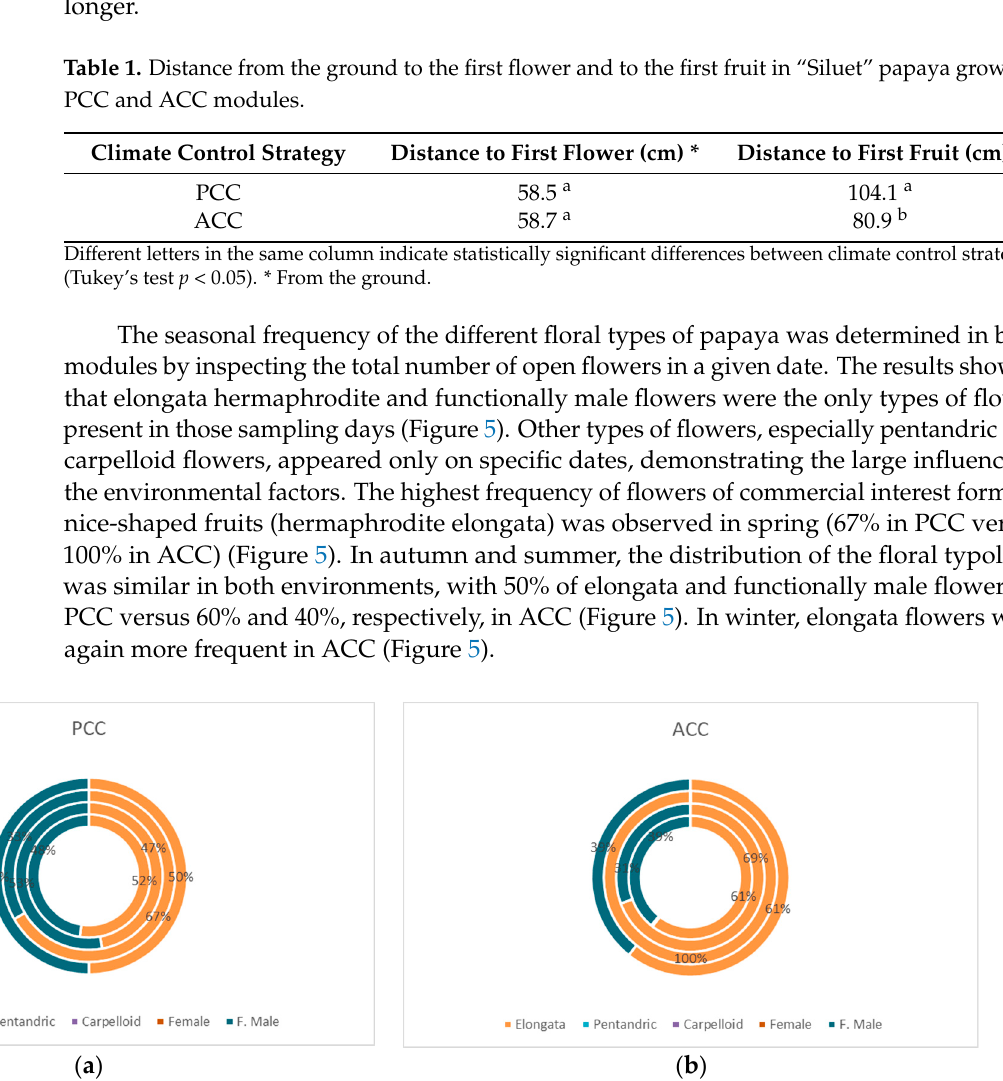
Table 2. Total and commercial yield, discards (%), fruit number per plant, and fruit weight in “Siluet” papaya grown in passive climate control (PCC) and active climate control (ACC) modules.